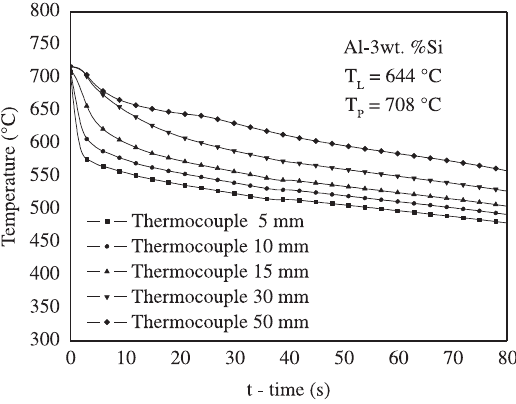
Figure 2. Experimental thermal responses of temperature vs. time for five thermocouples located at different positions from the metal-cooling chamber interface. T is the initial melt temperature. P